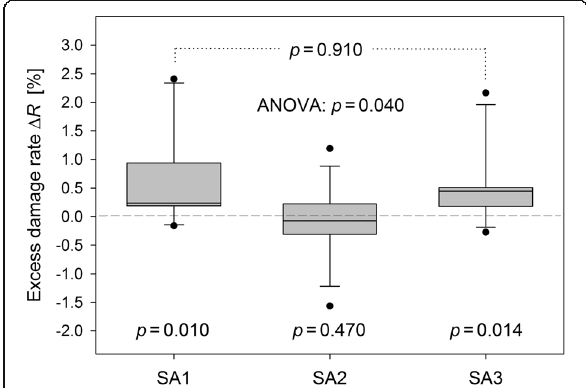
Fig. 8 Excess damage rates determined for lymphocytes fixed and isolated from blood samples taken before (SP1/IT60) and after (SP3/ IT60) exposure of volunteers in the three study arms. (Excess per study arm, Wilcoxon test; overall differences between study arms, Kruskal-Wallis test; differences between SA1 and SA3, Mann-Whitney